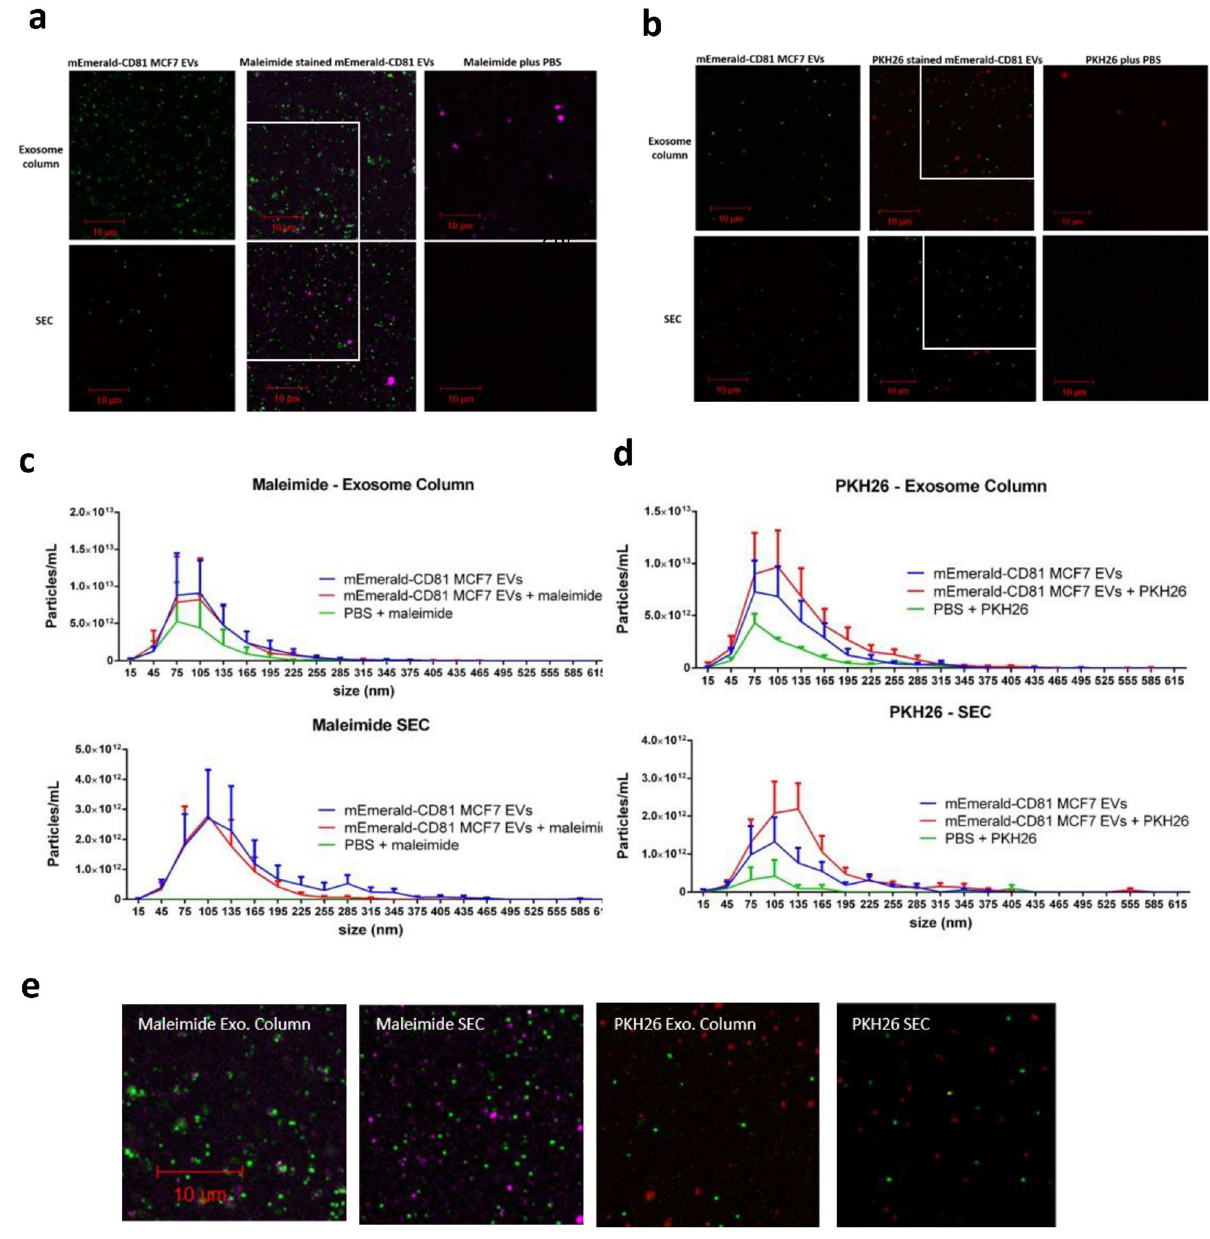
Figure 2. EV stains generate contaminating aggregates. mEmerald-CD81 MCF7s EVs or PBS controls were stained with PKH26 or Maleimide, then excess dye was removed with exosome spin columns (Invitrogen) or a consecutive round of SEC. mEmerald-CD81 MCF7 EVs were stained with maleimide ( a ) or PKH26 ( b ) and stain alone plus PBS (no EVs) were set in 1% (w/v) agarose, a coverslip placed on top and imaged on a Zeiss LSM880 confocal using 100 × objective. Representative images are shown. Particle size and concentration was analysed by NTA for maleimide ( c ) and PKH26 ( d ) stained mEmerald-CD81 MCF7s. A digital zoom. ( e ) is shown for maleimide and PKH26 stained EVs prepared using Exosome columns or SEC as indicated. Scale bar = 10 µm. N = 3 (Biological), error bars =